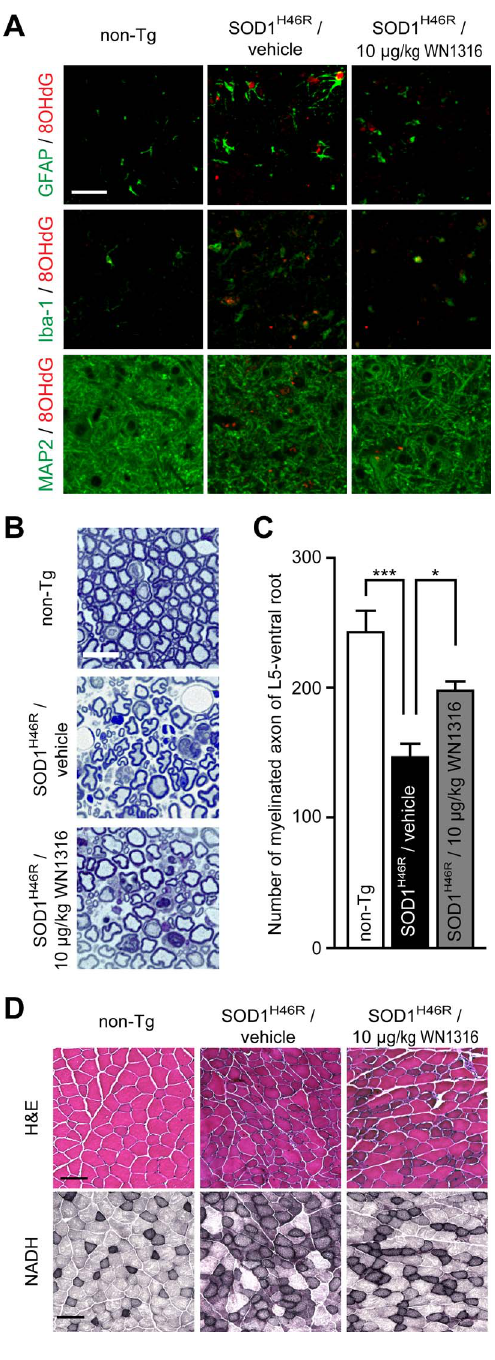
Figure 7. The WN1316 treatment mitigates oxidative damage to DNA and degeneration of axon and muscle. (A) Immunohis- tochemical analysis of paraffin embedded sections of the lumbar spinal cord from non-Tg, vehicle-treated ALS(SOD1 H46R ), and 10 m g/kg WN1316-treated ALS(SOD1 H46R ) mice at 21–22 weeks of age (late symptomatic stage). Representative merged images of double immun- staining with 8OHdG (red) and GFAP (for astrocytes) (green), Iba-1 (for microglia) (green), or MAP2 (for neurons) (green) are shown. Scale bar indicates 50 m m. (B) Representative toluidine blue staining of the transverse section of L5 ventral root from non-Tg, vehicle-treated ALS(SOD1 H46R ), and 10 m g/kg WN1316-treated ALS(SOD1 H46R ) mice at 21–22 weeks of age (late symptomatic stage). Scale bar indicates 20 m m. (C) Quantitative analysis of large myelinated axon numbers in L5 ventral root. Data are expressed as mean 6 SEM (n=4). * p , 0.05, ***